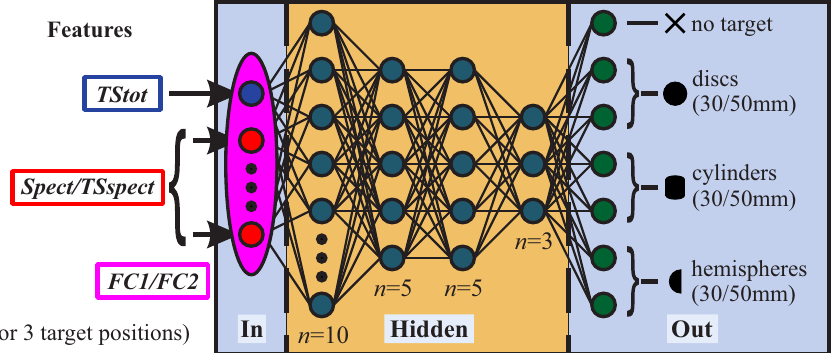
Figure 4. ANN architecture, with features, input, hidden as well as output layers, output classes and node numbers n